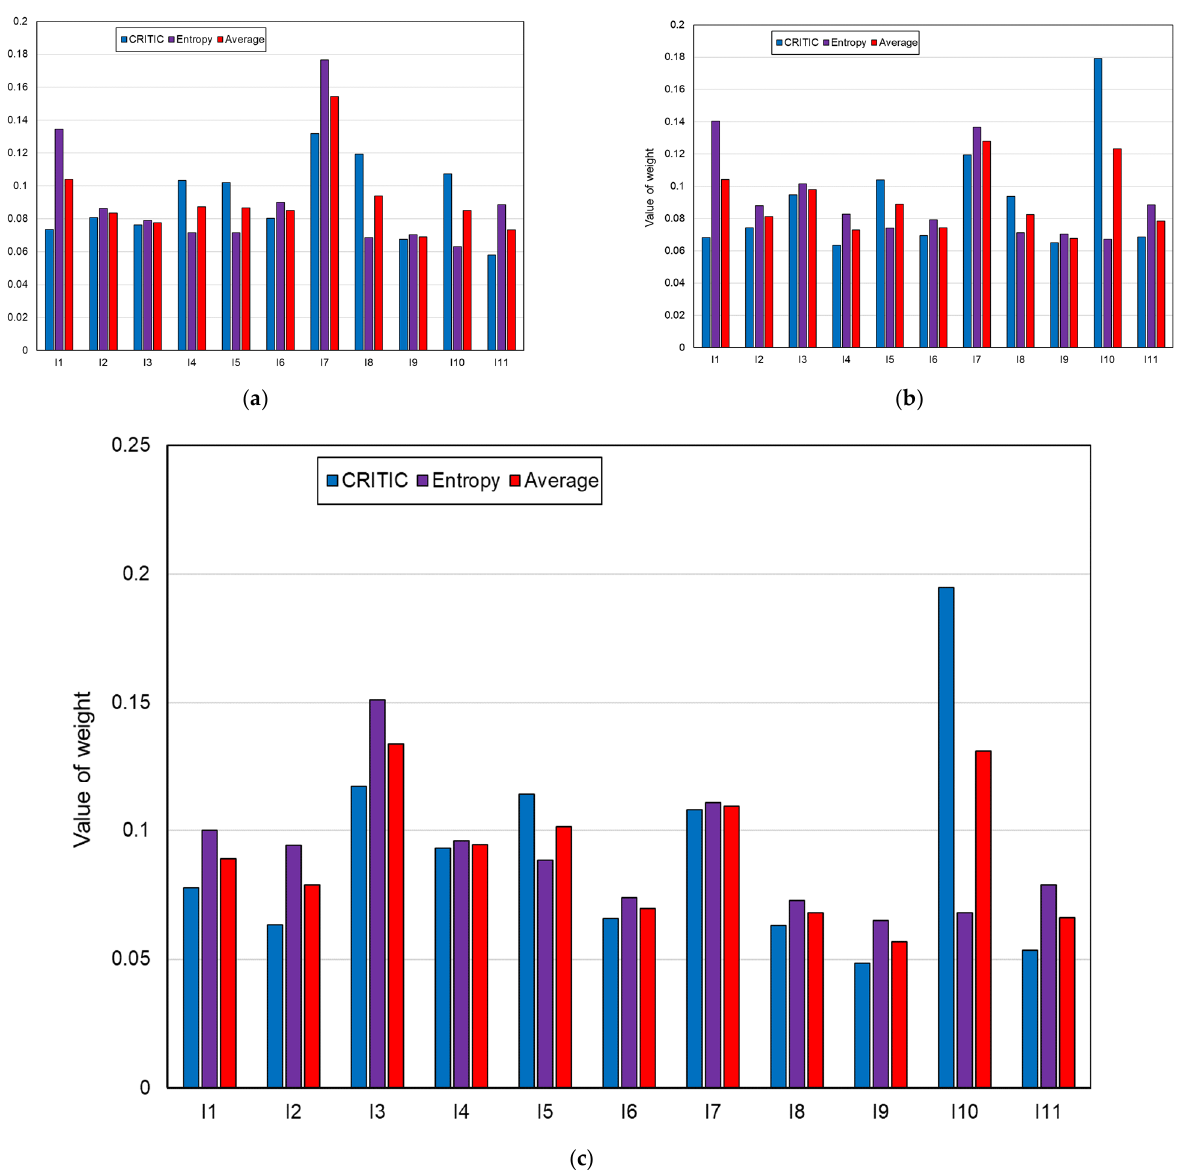
Figure 6. The values of indicator weights for small ( a ), medium ( b ) and large ( c ) enterprises. Table 8. Distance of individual CEE countries from the pattern and anti-pattern together with the TOPSIS measure for the level of digitalization of individual groups of enterprises. Enterprises Small Small Small